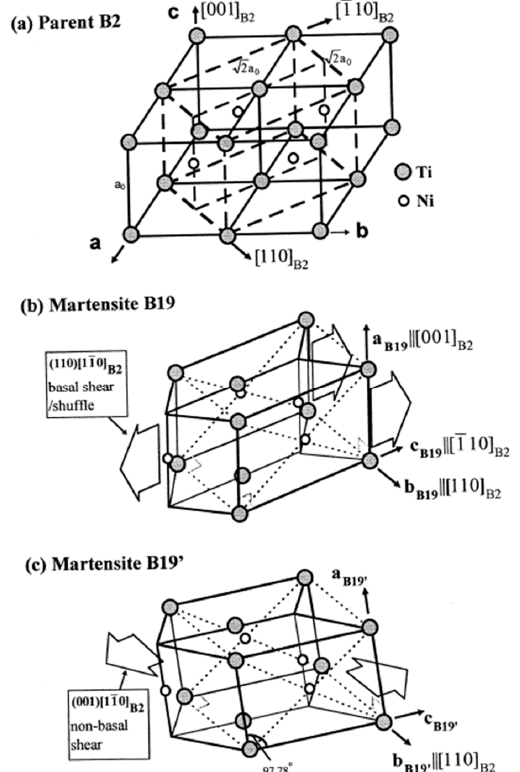
Figure 1. Relationship between the B2 parent crystal and one of its B19 ′ monoclinic daughter variants, from Otsuka and Ren [13,38]. The authors imagined the transformation in a sequential way with the help of the intermediate orthorhombic phase B19. The B19 would be formed by a stretch/shuffle along the [110], [1 1(cid:3364) 0], and [001] B2 directions, and the B19 ′ would then result from an additional shear on the plane (001) B2 along [1 1(cid:3364) 0] B2 .